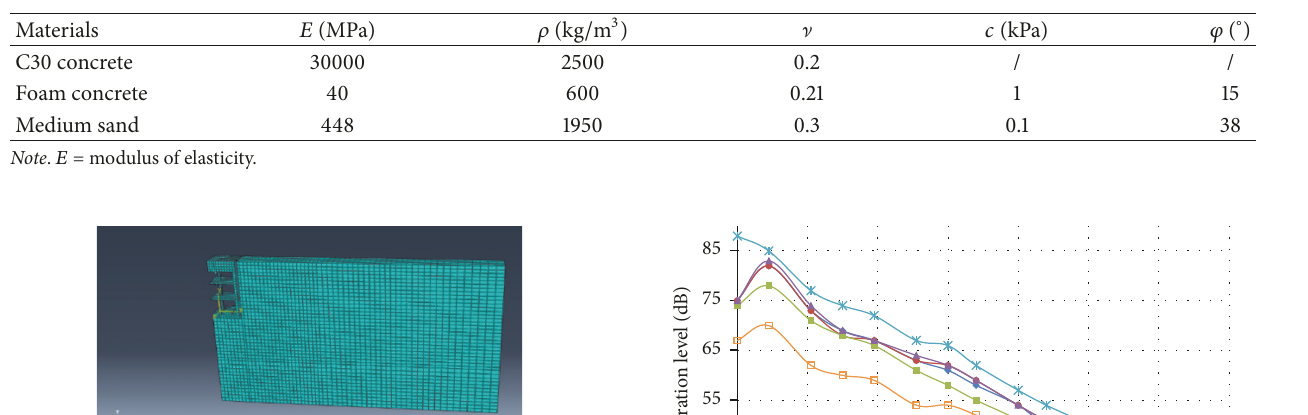
Table 3: Parameter of foam concrete, medium sand, and C30 concrete.